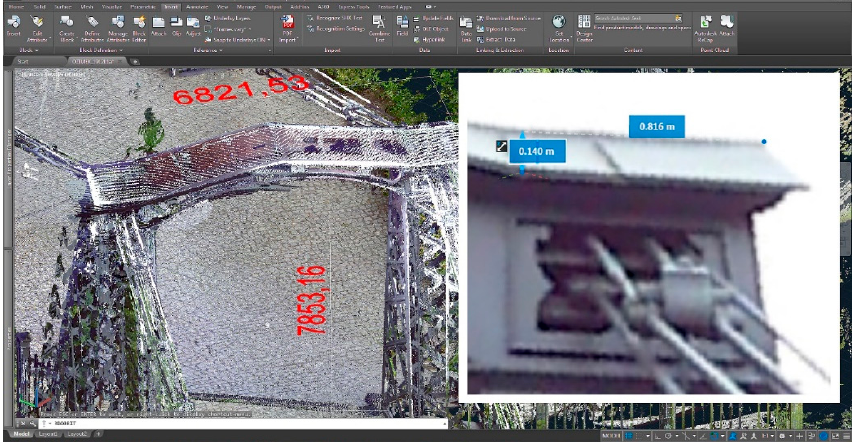
Figure 10. Example of dimensioning the bridge pylon in the AutoCad environment.